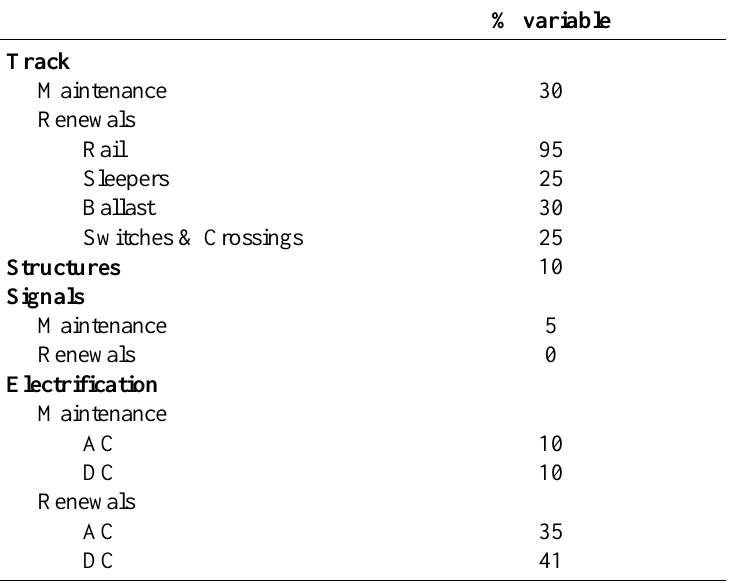
Table 3. Cost variability by asset